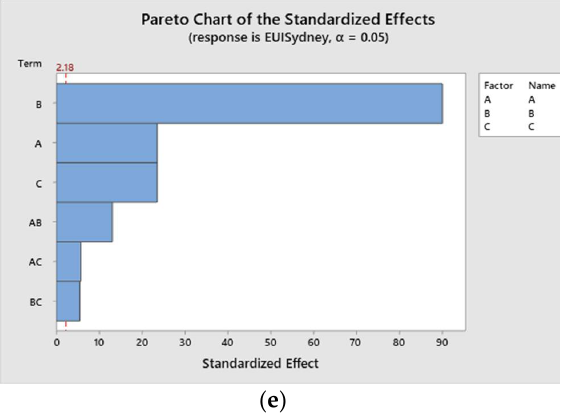
Figure 7. Correlation significance between the factors considered. ( a ) Armação dos Búzios; ( b ) Capri; ( c ) Punta Cana; ( d ) Dubai; ( e ) Sydney.